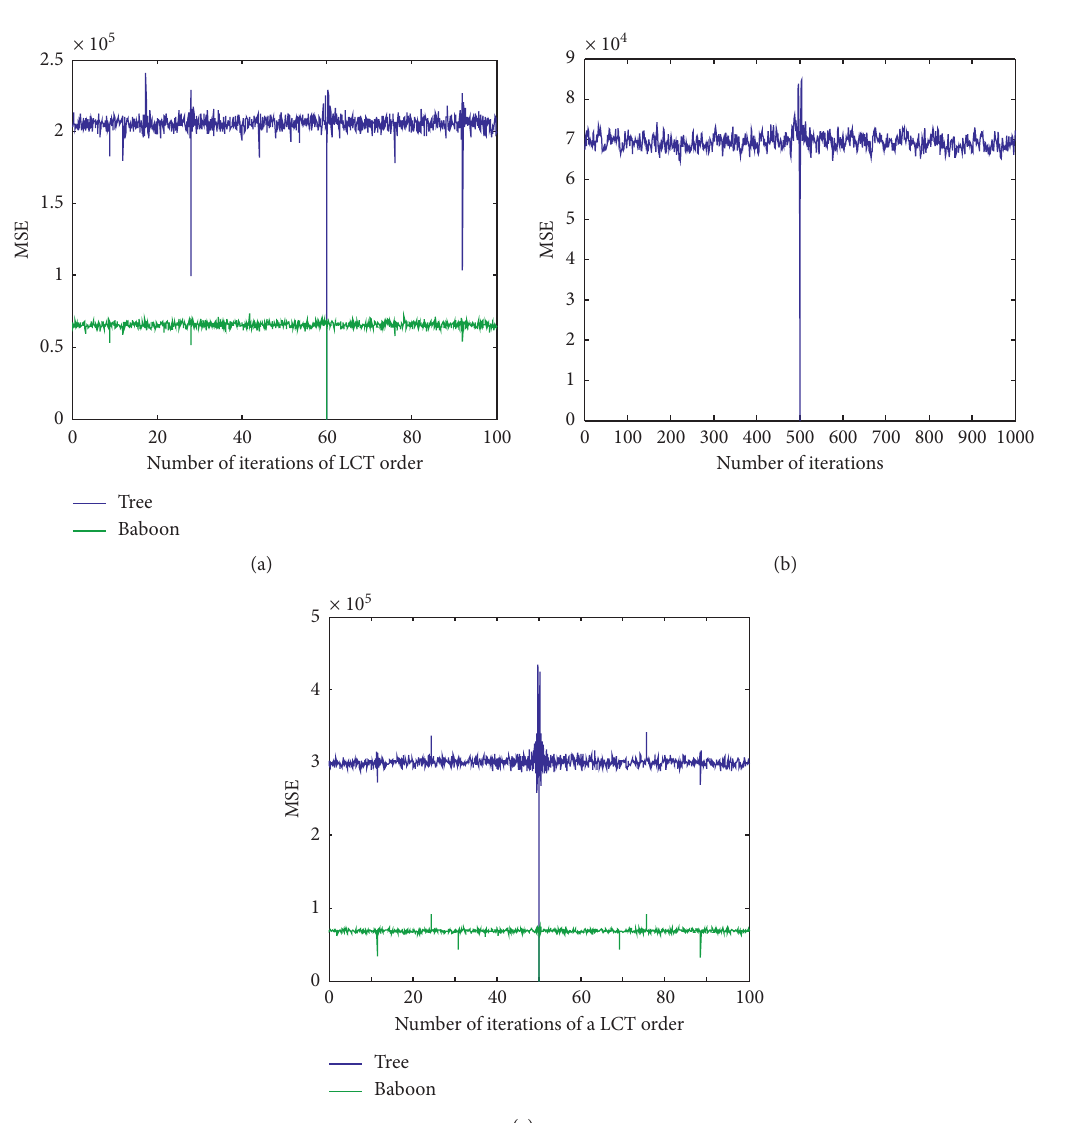
Figure 8: (a) MSE plots and the number of iterations of first LCTorder; (b) MSE plot against the number of iterations for single image; (c) MSE plot and the number of iterations of second LCT